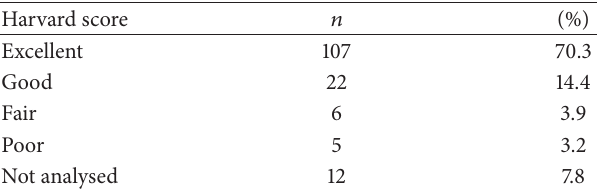
Figure 4: Kaplan-Meier overall survival estimate. Table 4: Late cosmetic outcomes.